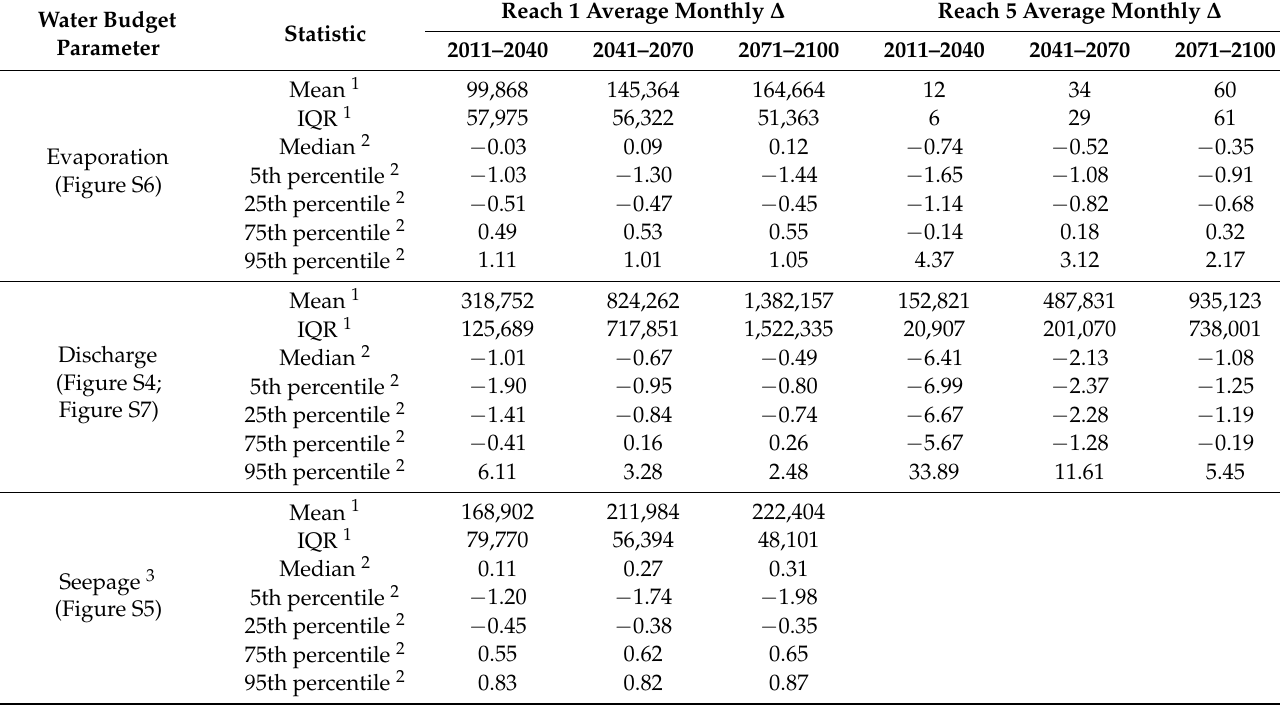
Table 7. LULCCC Scenario Water Budget Component Results for Reach 1 and